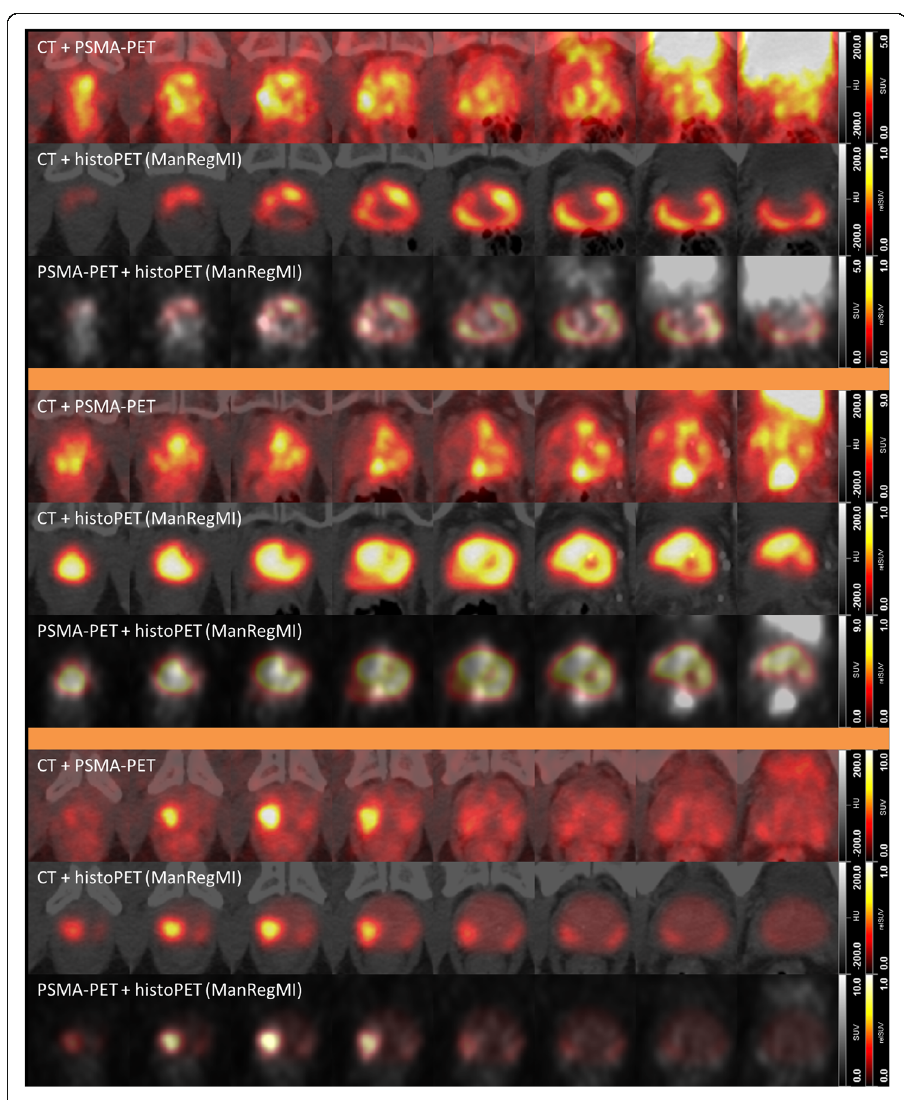
Fig. 8 Visual agreement according to ManRegMI coregistration. Overview of axial layers (every 4 mm) throughout the prostate volume for patients 1 ( top ), 2 ( middle ), and 3 ( bottom ) for the ManRegMI coregistration. The images in each row are ordered from apex ( left ) to basis ( right ). For each patient, PSMA-PET and histoPET are presented separately from each other, with CT overlay for better orientation. The last row in each image shows the direct comparison of PSMA-PET and histoPET. Note that some discrepancies between PSMA-PET and histoPET, such as the pronounced PSMA-PET signal at the dorsal and cranial prostate region for patient 2 ( middle image ), may be due to missing histopathologic information. Such regions were excluded from the further quantitative analysis in order not to bias the